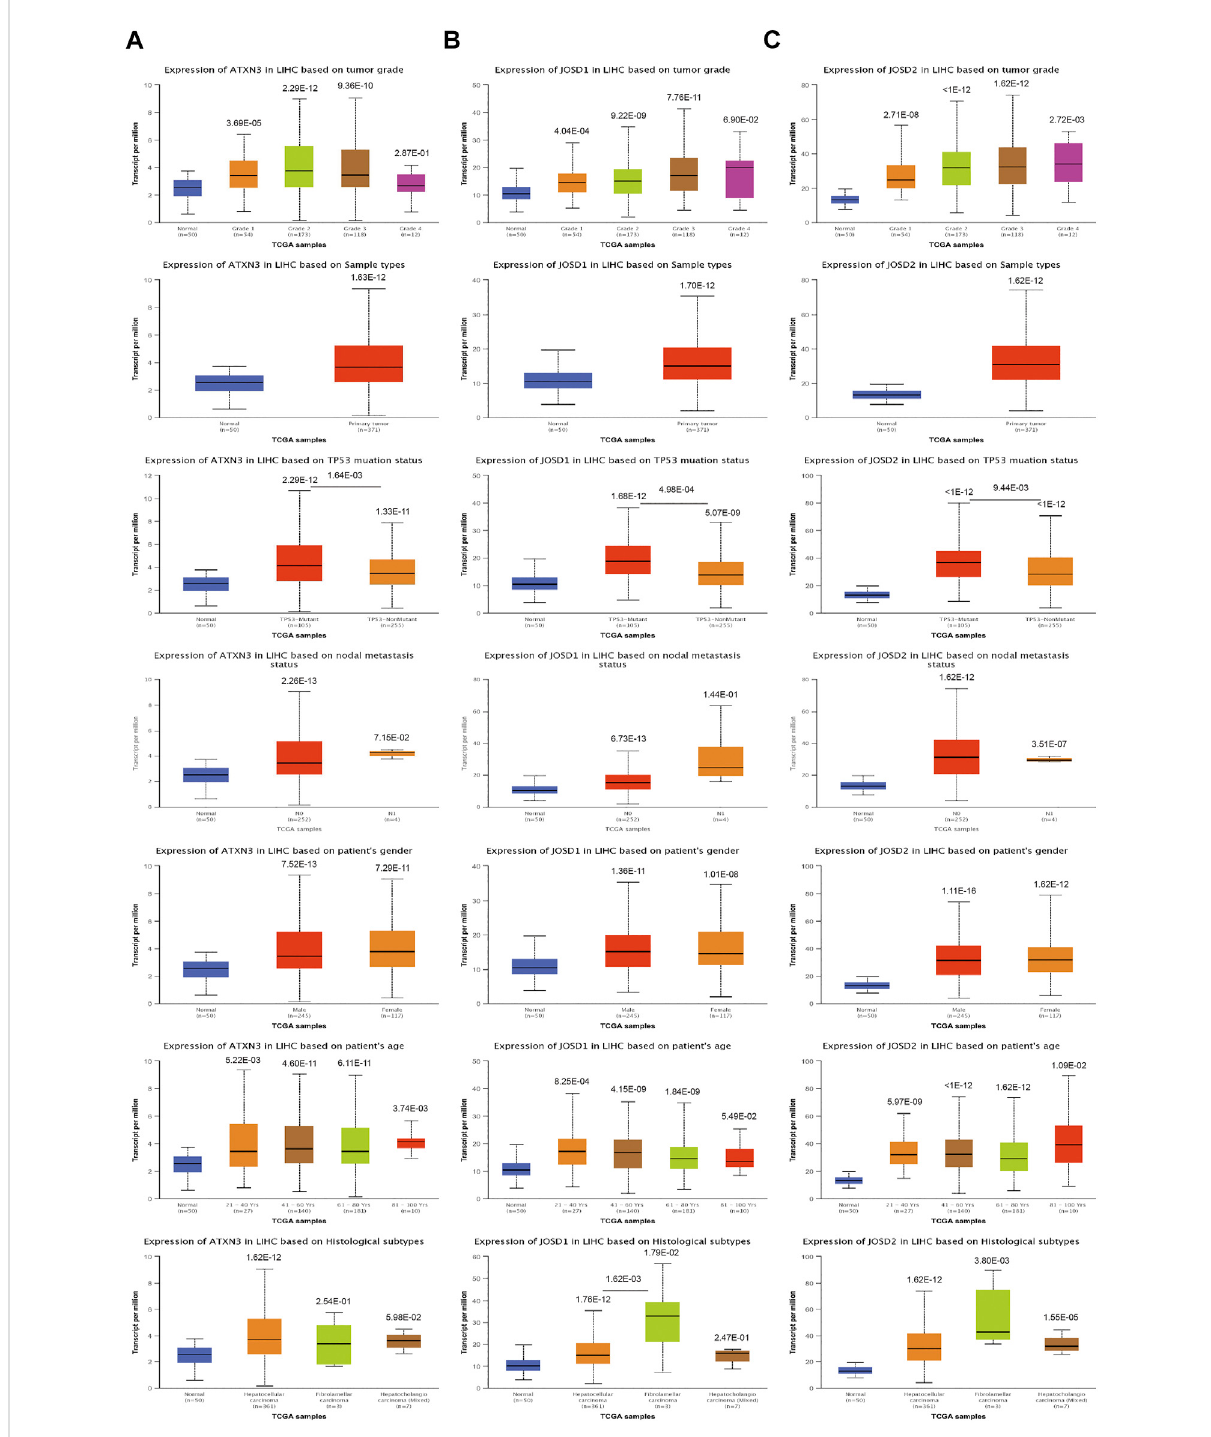
FIGURE 2 (A – D) The transcription level of MJDs family members in the subgroup of HCC patients, and classi fi ed by according to histological grades, sample types, TP53 mutations, lymph node metastatic status, genders, years and histological